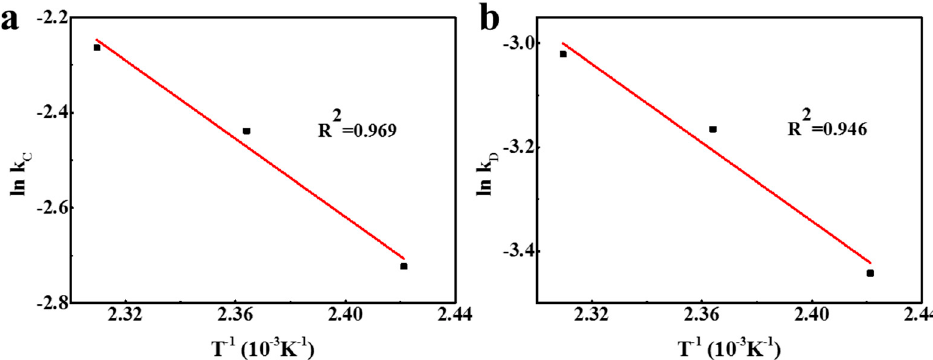
Figure 13. Relationship between reaction rate constant ( a ) k C –T − 1 ; ( b ) k D –T − 1 of lepidolite during leaching process.